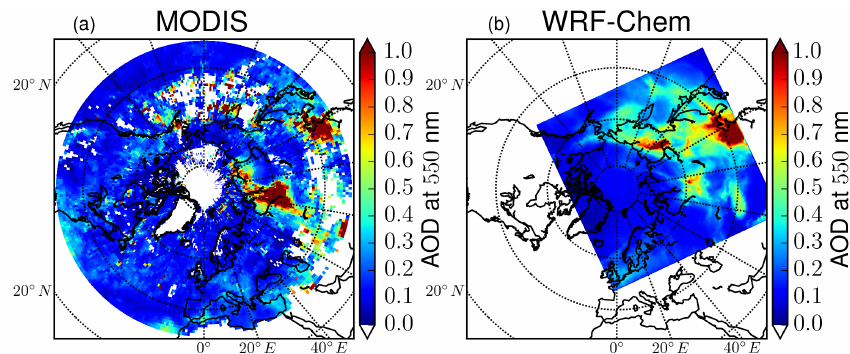
Figure 4. Aerosol optical depth (AOD) at 550nm (a) measured by MODIS instrument aboard Aqua and (b) simulated by a Mie code in the WRF-Chem model, averaged between 4 and 21 July 2012. White areas in panel (a) indicate the presence of clouds, preventing the AOD